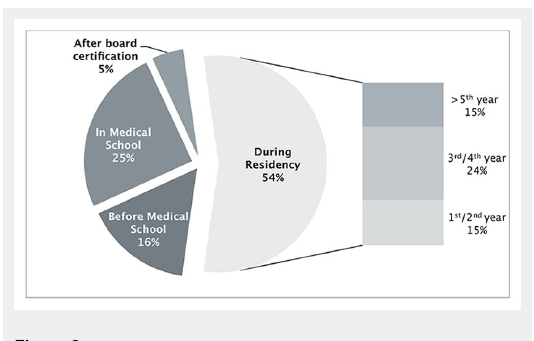
Employment of currently working general practitioners. (p <0.05 between the sexes). x-axis: year of title received and sex of participants. y-axis:the height of the bar represents the percentage of the participants that were currently working in general practice.